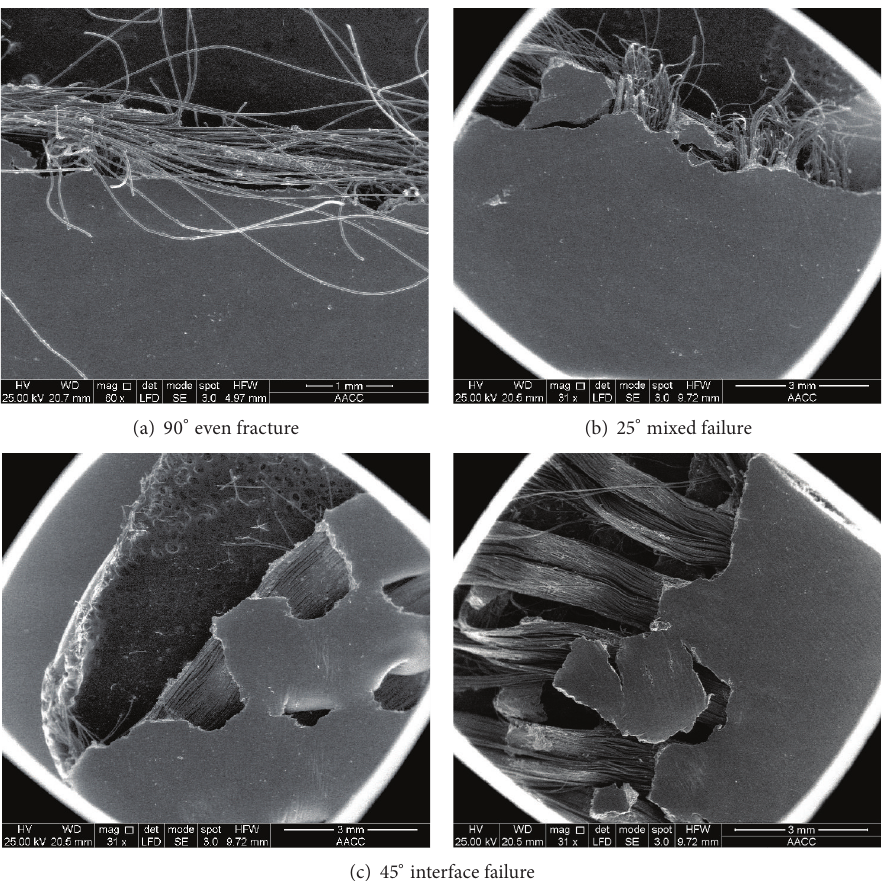
Figure 6: SEM images of fractographics of off-axial specimens.